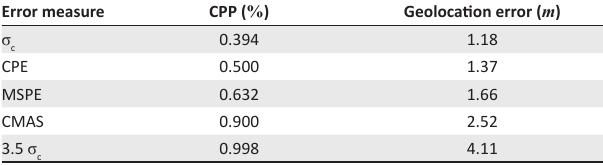
TABLE 2: Statistical measures describing the horizontal geolocation